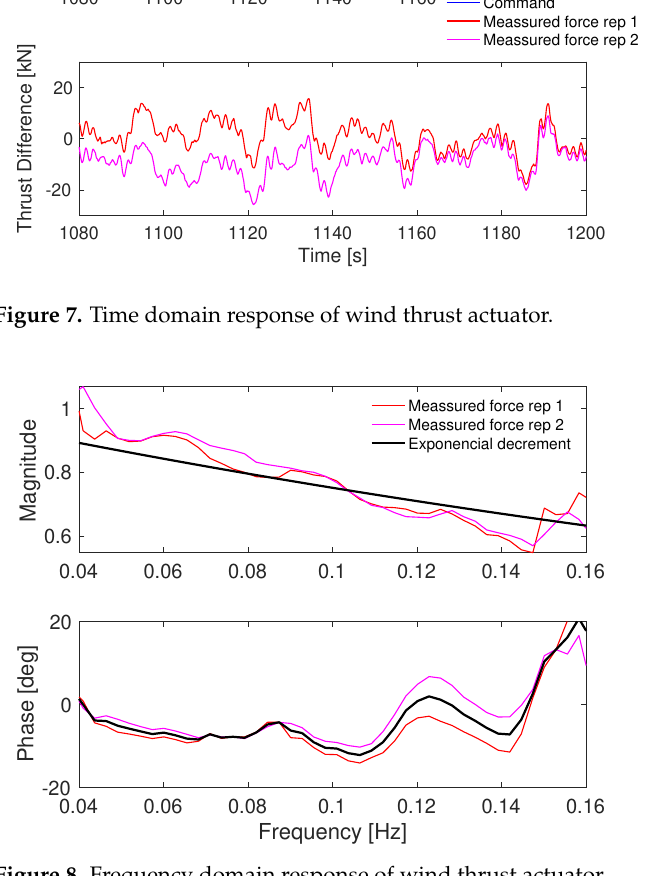
Figure 8. Frequency domain response of wind thrust actuator.